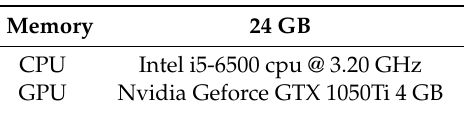
Figure 20. Stepping motor 42BYGH4417 NEMA 17.